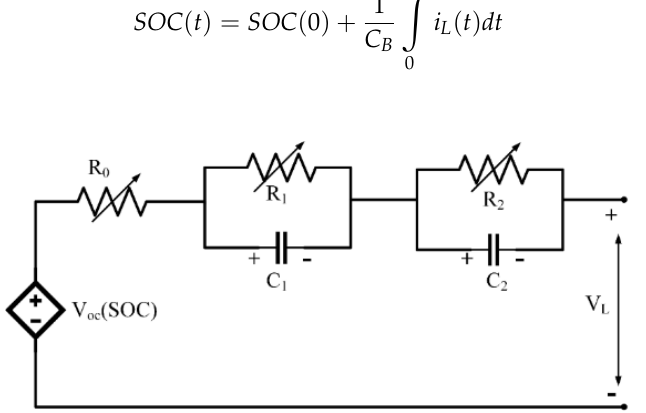
Figure 36. The Thevenin equivalent circuit for modelling batteries. All the parameters in the equivalent circuit are dependent on the state of charge (SOC) of the battery [69]. circuit are dependent on the state of charge (SOC) of the battery